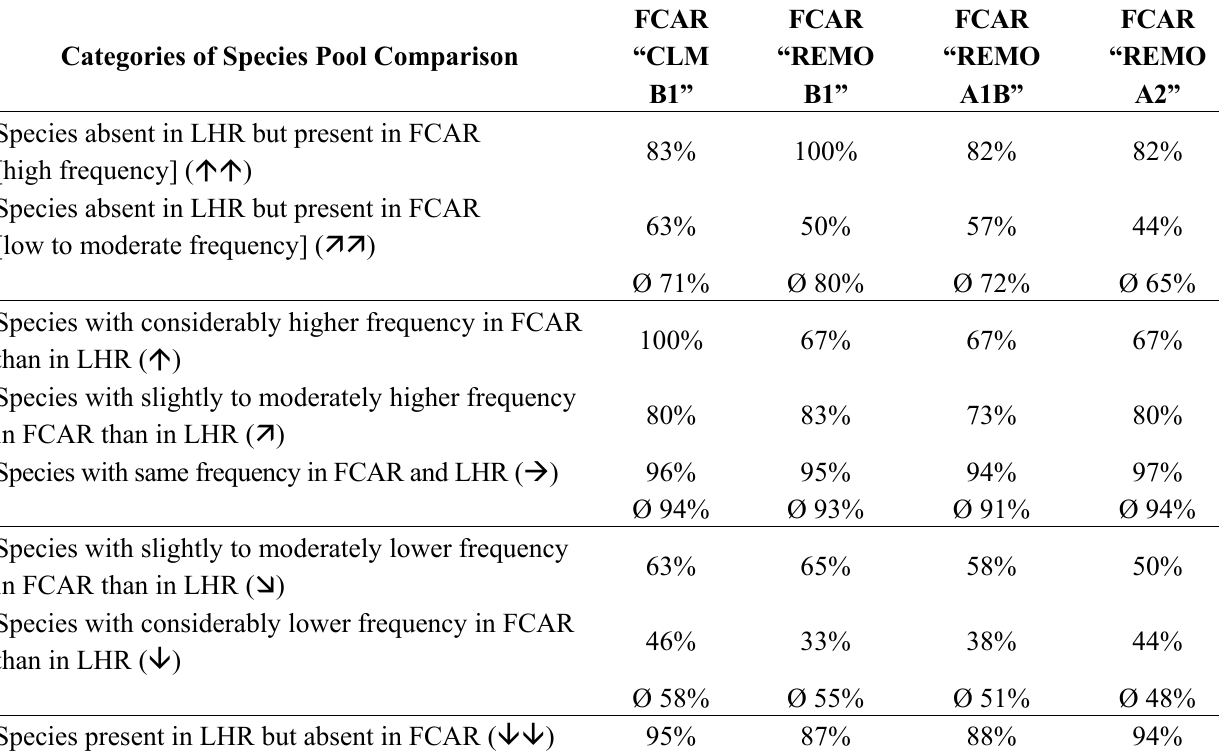
Table 3. Degree of conformity of the species pool comparisons’ results, including the frequency within a region, with the results of Huntley et al. [18] for the